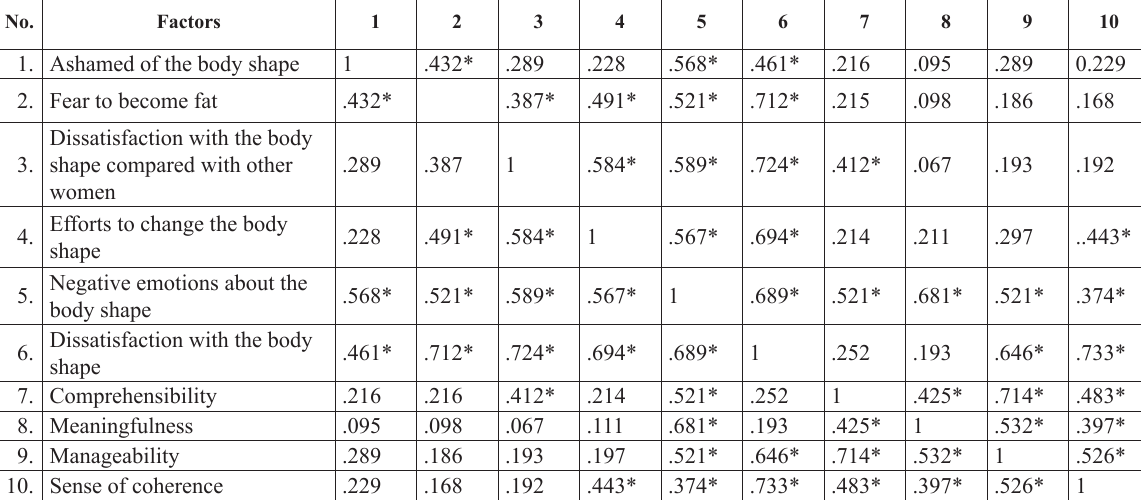
Table 3. Correlation coefficients between the factors No.